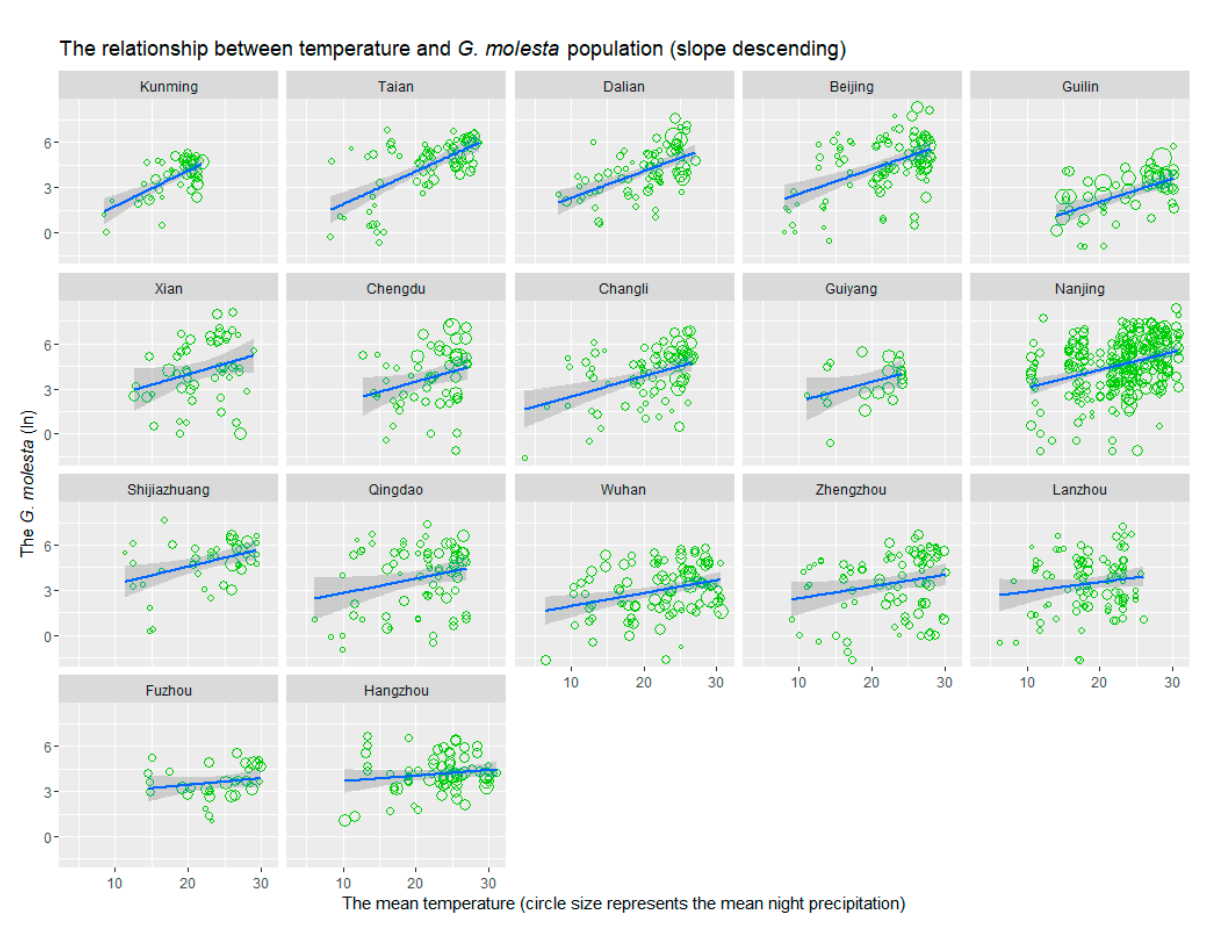
Figure 3. The relationship between mean temperature and G. molesta populations in 17 experimental sites in China.